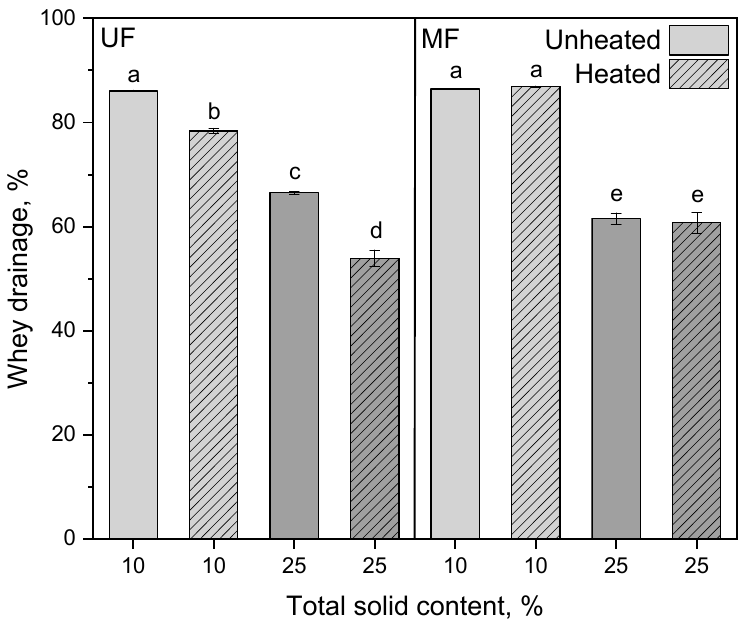
Figure 6. Whey drainage after incubation (t = 1 h, ϑ = 40 ◦ C) and centrifugation at 4000 × g (t = 45 min, ϑ = 20 ◦ C) of unheated and heated reconstituted UF and MF rennet gels with 10 and 25% total solid content. Letters indicate the statistical significance at p ≤ 0.05.